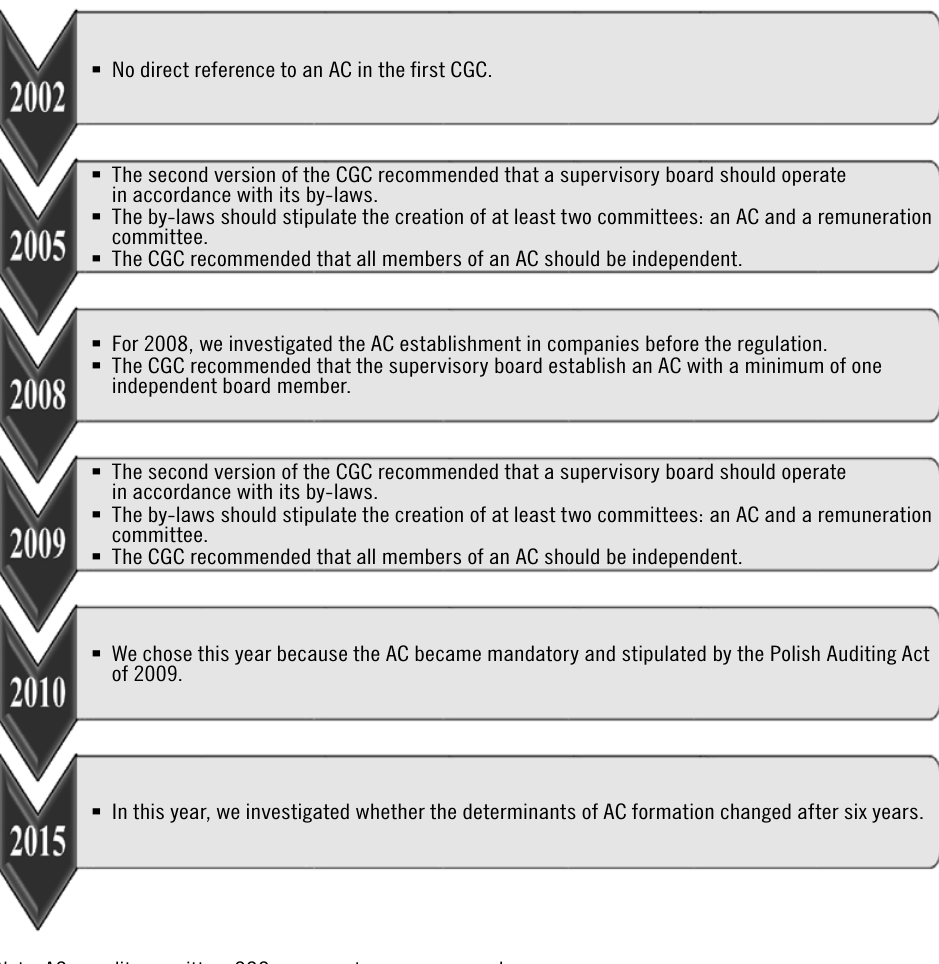
Figure 2. Audit committee regulation changes in Poland and the sample